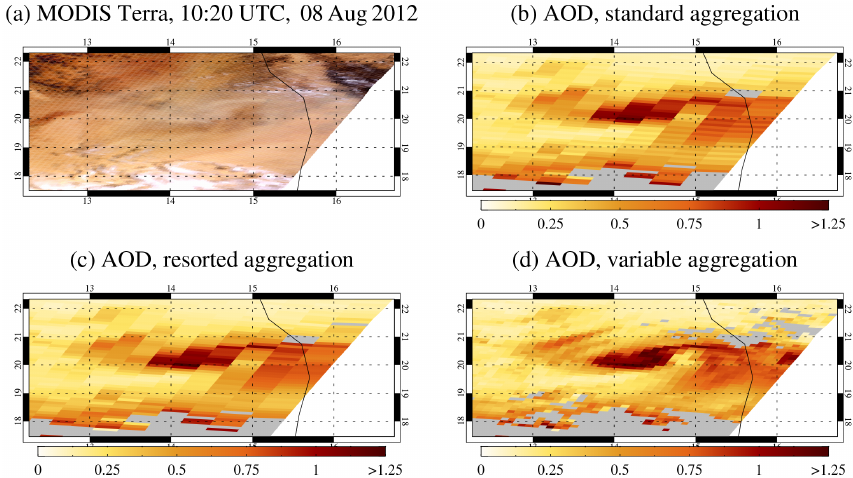
Figure 10. Effect of aggregation technique on spatial distribution of retrieved DB AOD at 550nm. Panel (a) shows a true-colour image for the eastern portion of the granule shown in Fig. 2, and panels (b–d) show the L2 AOD for each of the standard, resorted, and variable aggregation techniques respectively. Pixels without retrievals are shaded in